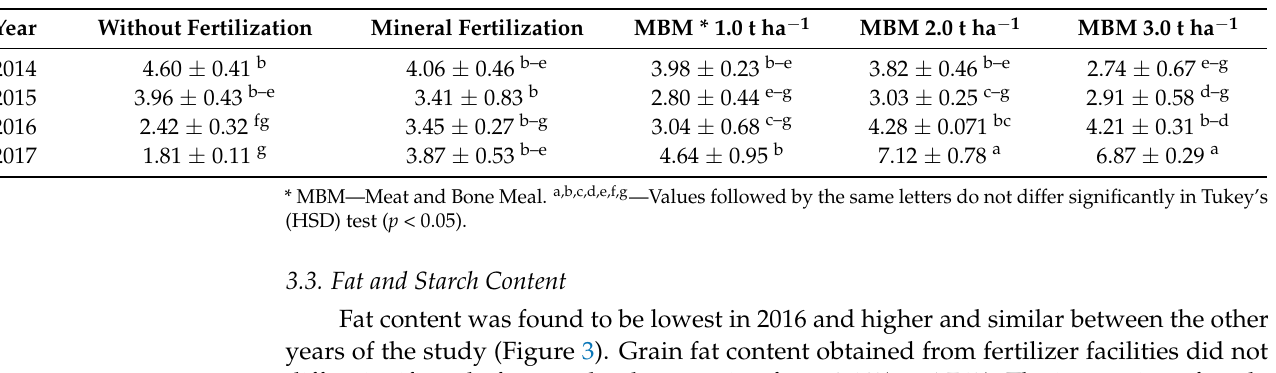
Table 5. The corn grain yield, interaction between the years and treatments (mean value and standard deviation), t ha − 1 .